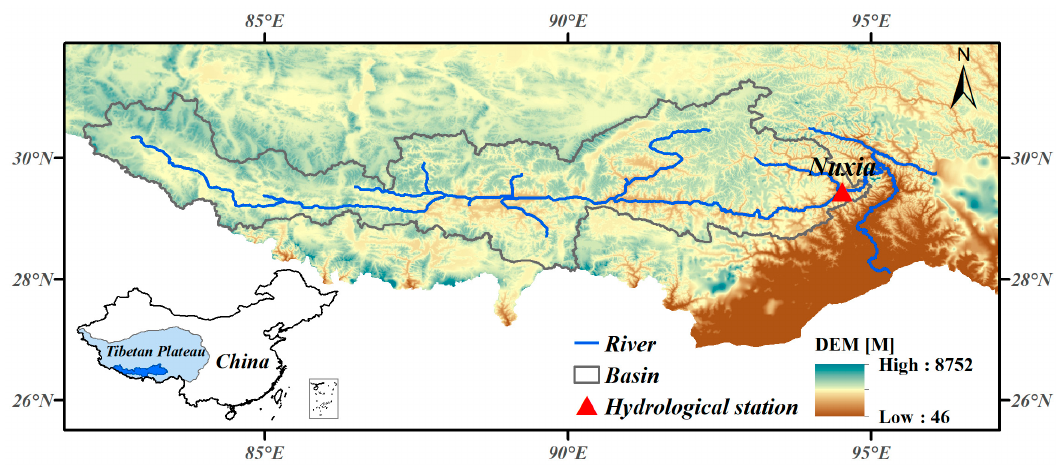
Figure 1. Map showing the upstream of Nuxia hydrological station of Yarlung Zangbo River basin.